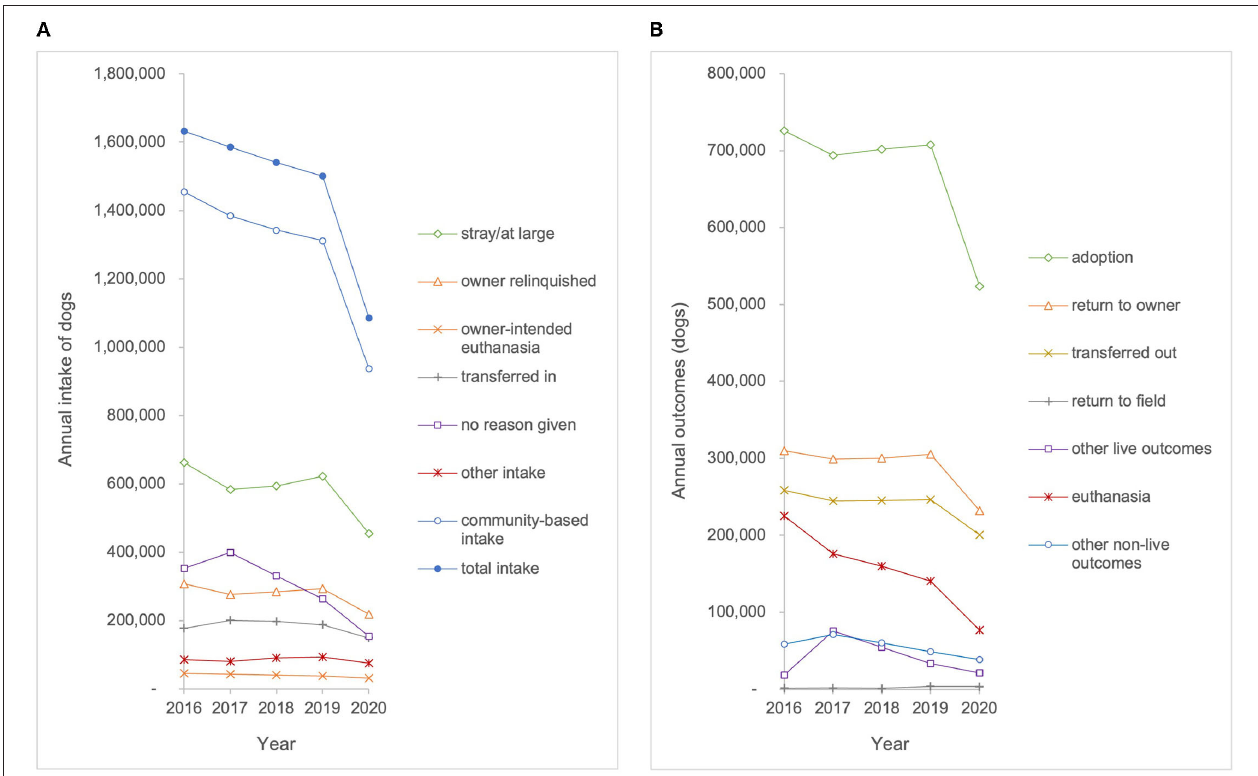
FIGURE 2 | (A) Annual intake and (B) annual outcomes for dogs entering the shelters in the sample population ( n = 1,131) from 2016 to